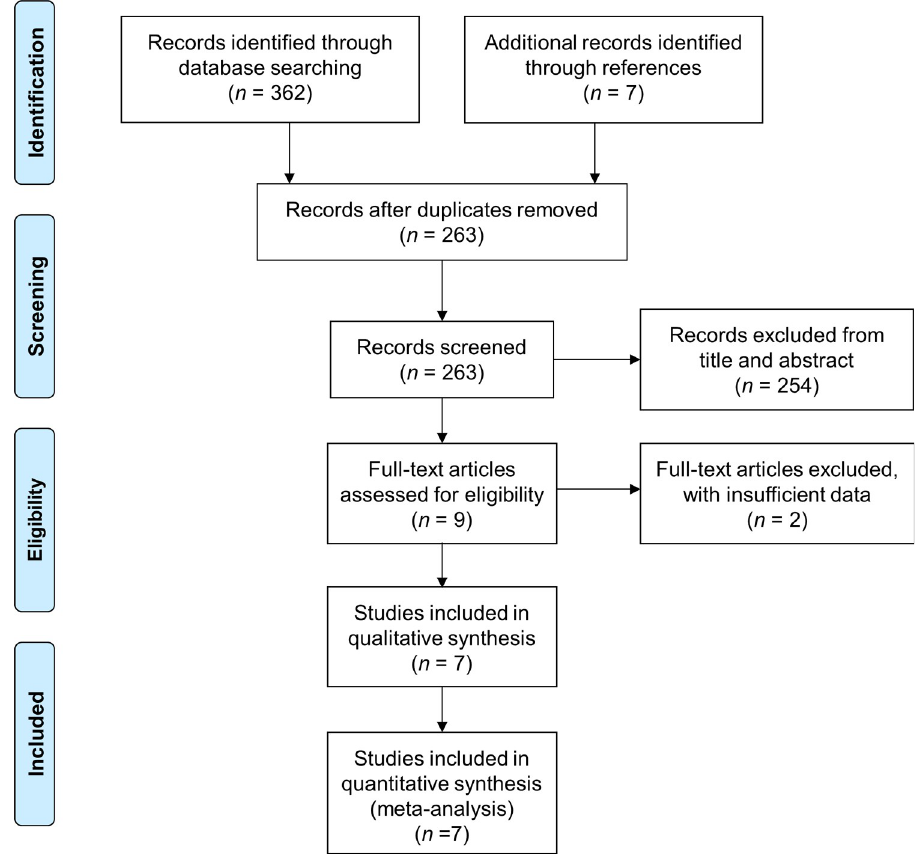
Fig 1. PRISMA flow chart for study